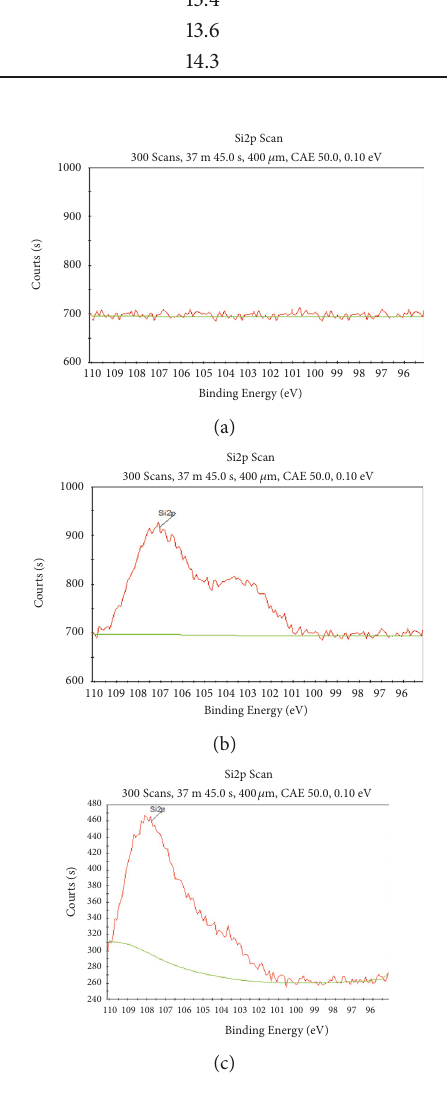
Figure 6: XPS spectra for Si 2p of (a) of WF, (b) WS5, and (c) original